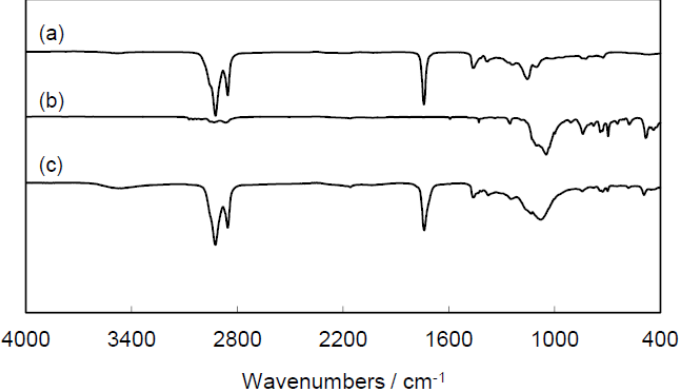
Figure 2. FT-IR spectra of ( a ) ESO; ( b ) POSS-1; and ( c ) ESO/POSS-1 nanocomposite (90:10 wt%).